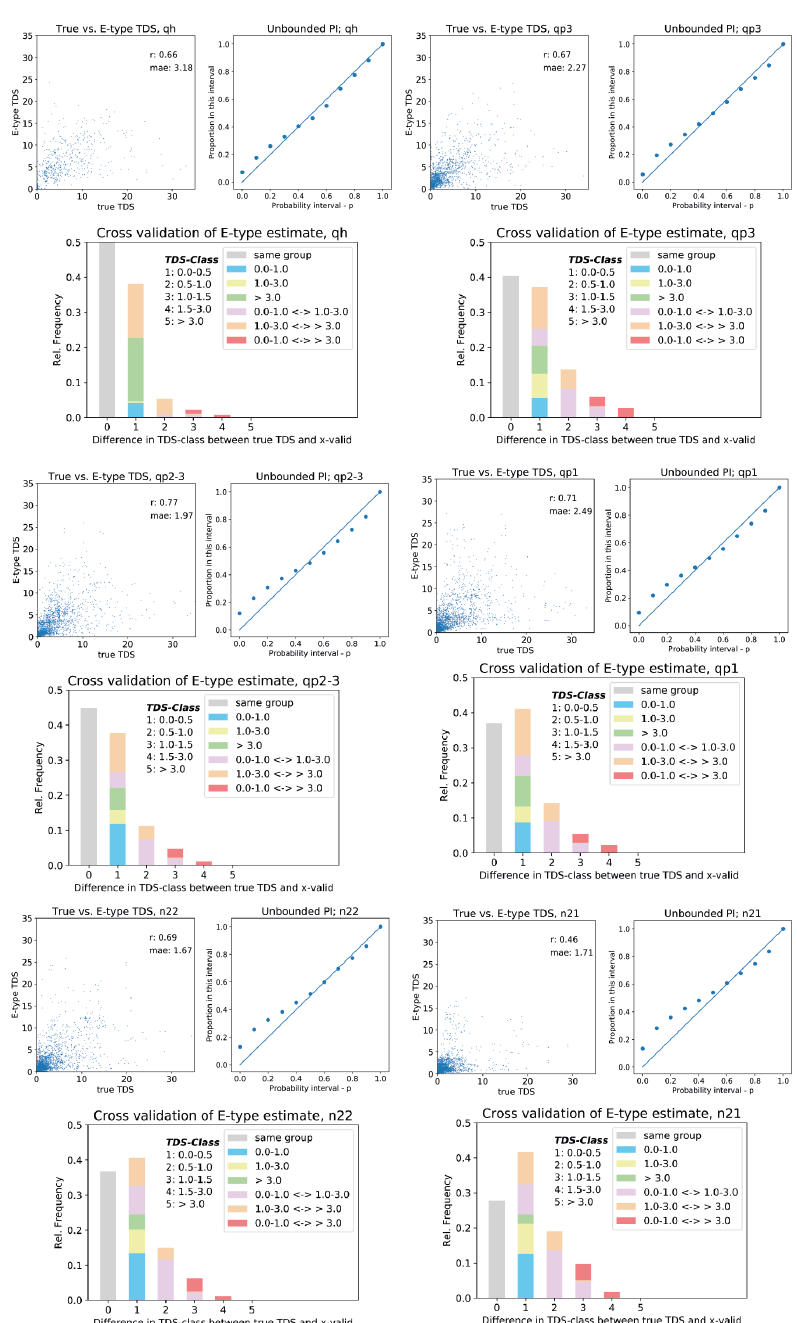
Figure F1. Results of the cross-validation per aquifer. Top left shows scatterplot of true versus E-type TDS estimate; top right indicates the accuracy of the interpolation by proportion of data that fall in a certain probability interval (PI); lower graph shows the summary of the cross-validation results concerning grouping of TDS values. For further explanation refer to the main